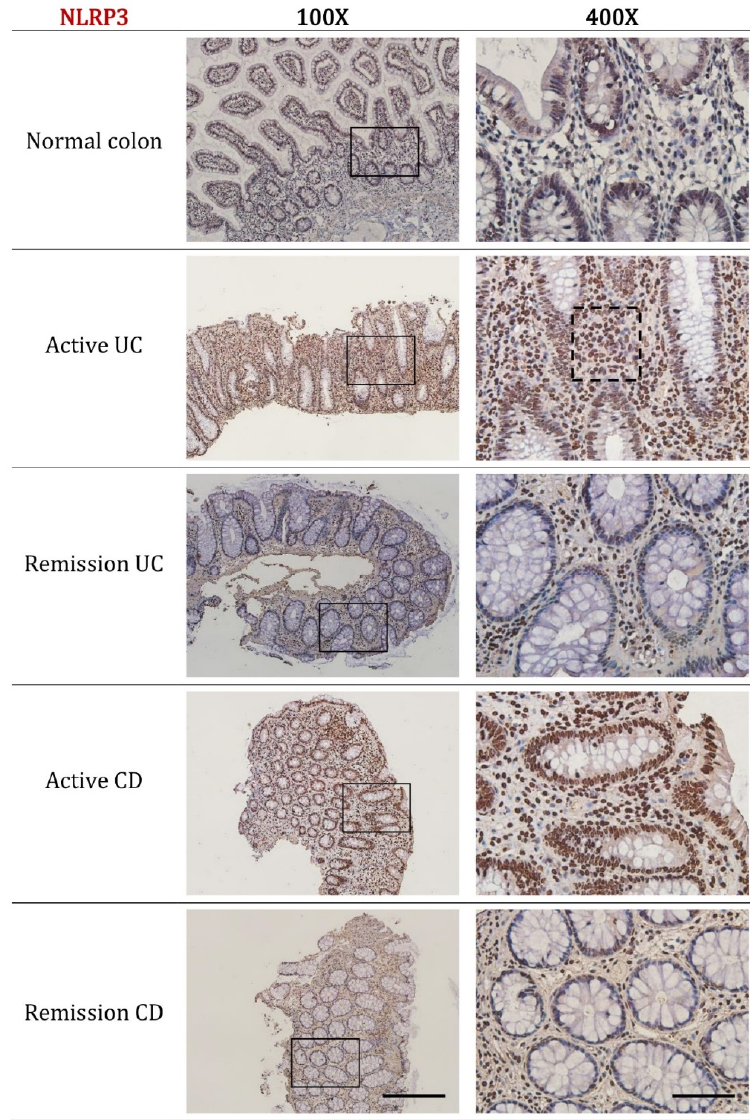
Figure 2. Representative immunohistochemistry images of NLRP3 expression in normal colon, active UC, remission UC, active CD and remission CD. All biopsies were taken from the left colon (unless otherwise stated as ileum biopsy), paraffin embedded, cut into 5 µ m sections and incubated with NLRP3 (ab17267, Abcam, Cambridge, MA, USA) at a dilution of 1:300. Disease diagnosis was confirmed by a practicing pathologist. Black dotted box indicates increased numbers of lamina propria neutrophils in active UC. Scale bars represent 200 µ m for 100 × and 50 µ m for 400 × magnification.